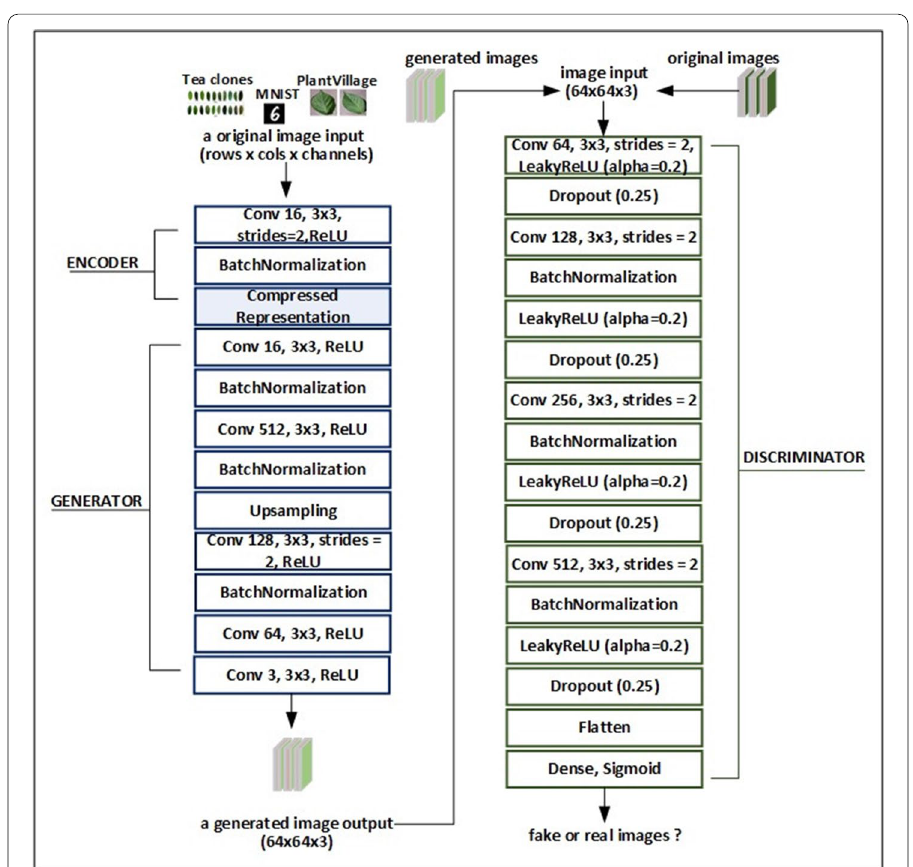
Fig. 6 Architecture of the proposed